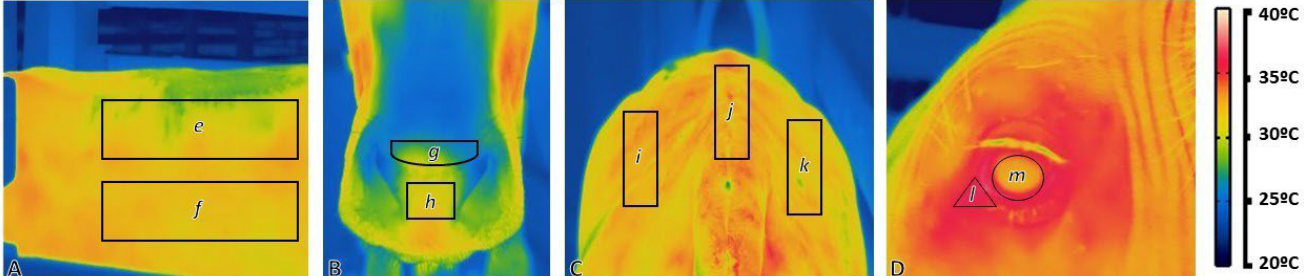
Figure 1. Thermographic images and subregions traced the left side of the body, muzzle, loin, and left eye in Caracu. ( A ) The left side of the body: e = upper (US), f = lower (LS); ( B ) Muzzle: g = caudal area of the muzzle (CM), h = middle of the muzzle (MM); ( C ) Loin: i = left (LL), j = middle (LM), k = right (LR); ( D ) Left eye: l = lacrimal canal region (LC), m = eye globe (EG). Rainbow palette: light colors indicate warmer temperatures (white) and, dark colors indicate cooler temperatures (dark blue), other colors indicate intermediate temperatures.